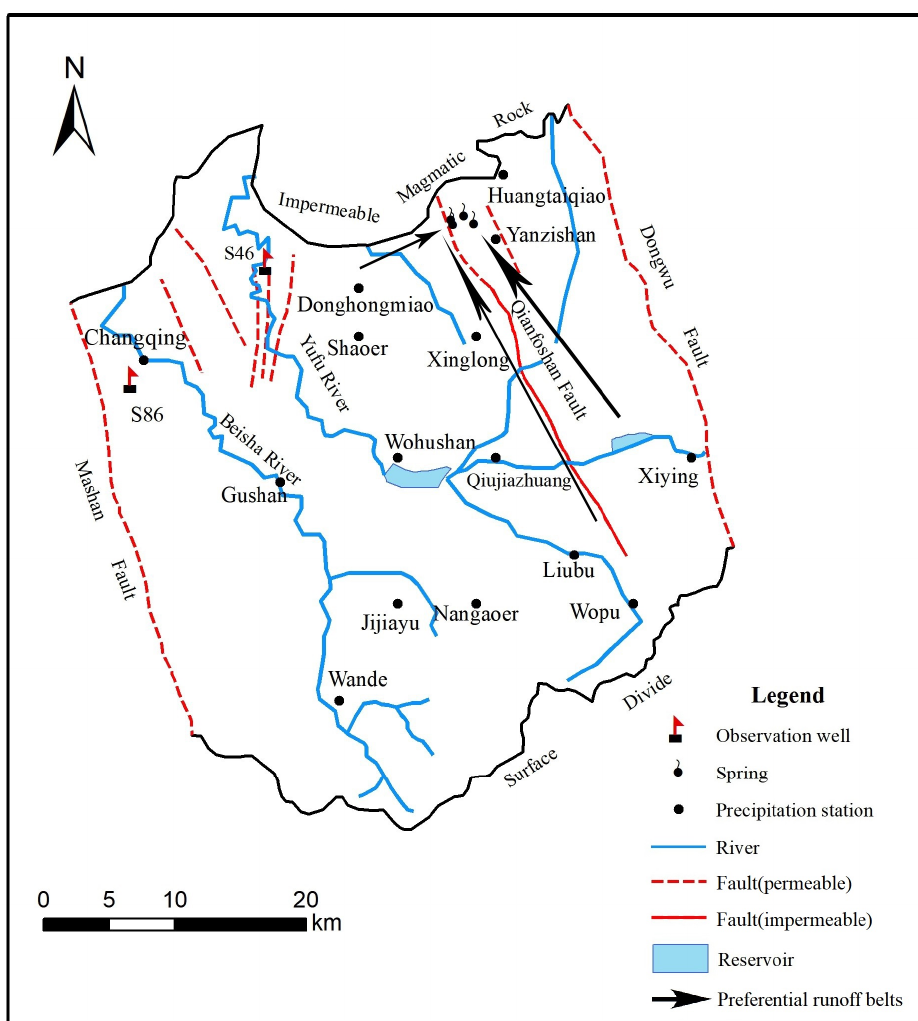
Figure 7. Location of preferential runoff belts in Jinan Spring Basin.